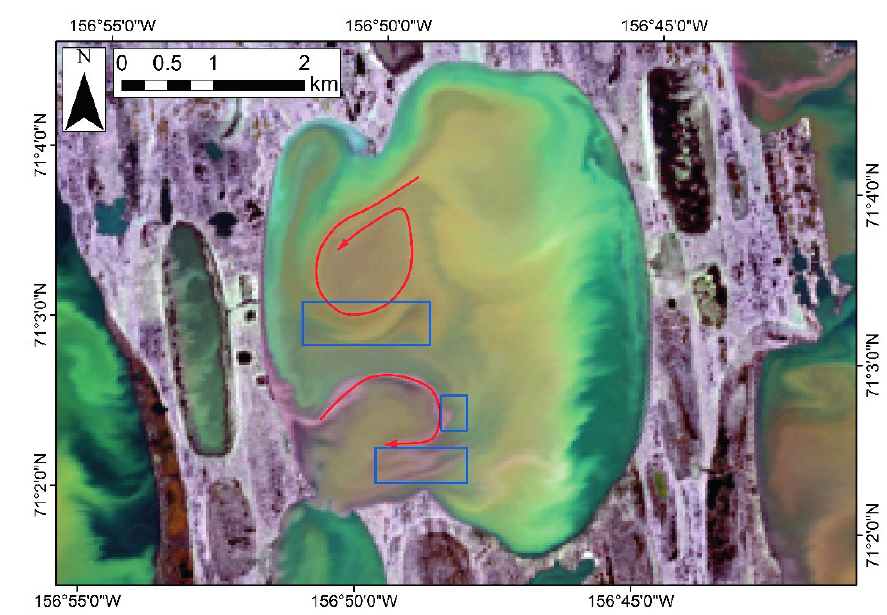
Figure 7. A clockwise and an anticlockwise gyre identified in one lake. Gyres flow in a direction in which its diameter gradually reduces. Therefore, the direction of gyres can be